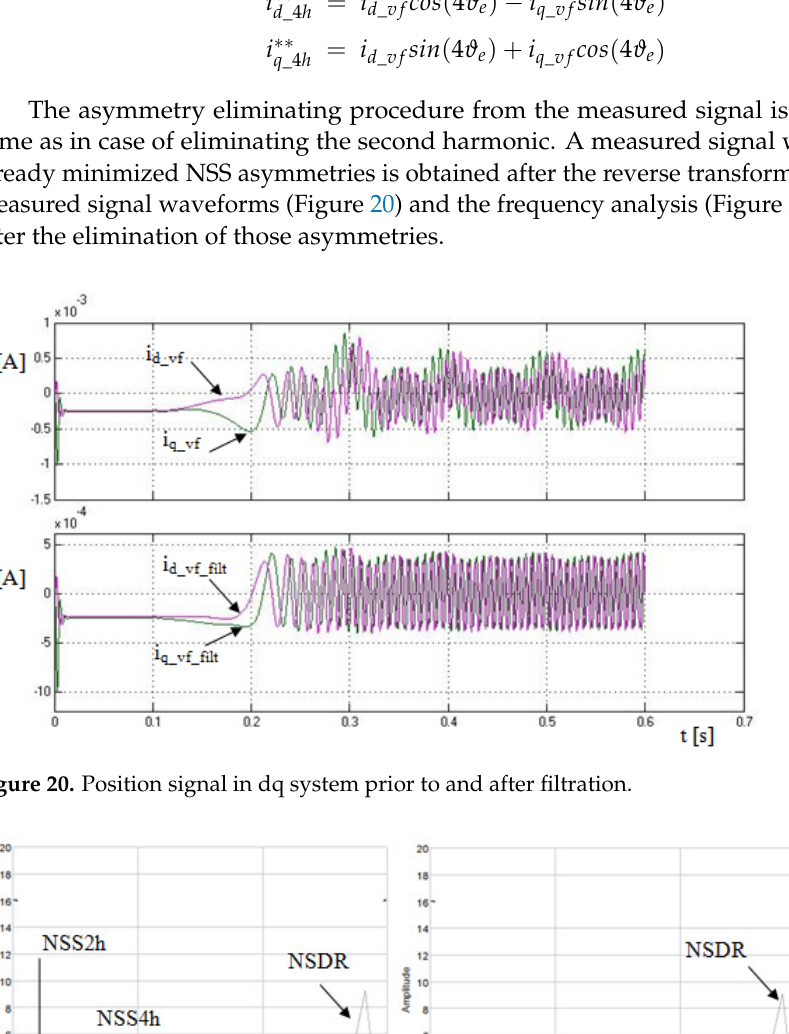
Figure 21. Frequency analysis of position signal prior to and after NSS filtering .